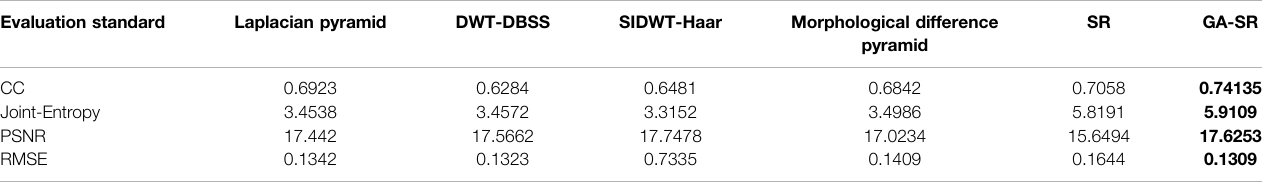
TABLE 1 | Quality evaluation of fused images of the fi rst group.